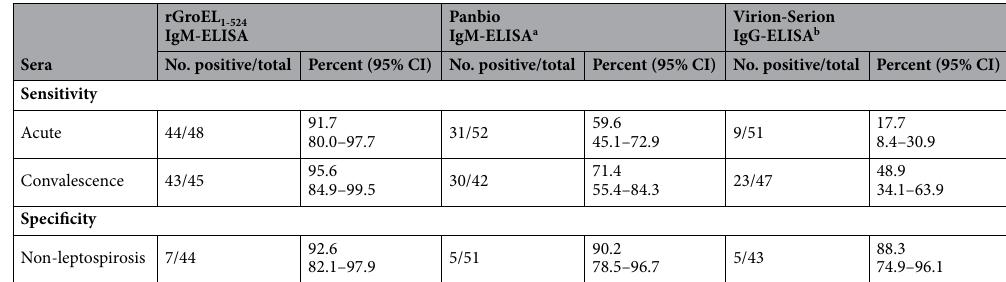
Table 1. Diagnostic performances of rGroEL 1-524 IgM-ELISA and commercial IgM-ELISA (Panbio) and IgG- ELISA (Virion-Serion) during the course of leptospirosis. a Optimized cut-off for Panbio IgM-ELISA was ≥ 7 panbiounits. b Optimized cut-off for Virion-Serion IgG-ELISA was ≥ 0.35 OD ELISA.